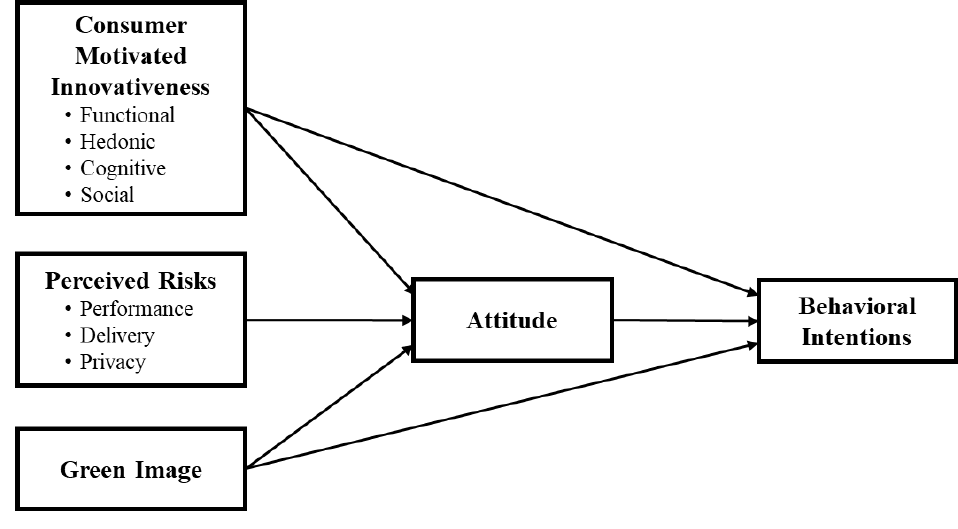
Figure 1. Theoretical model.